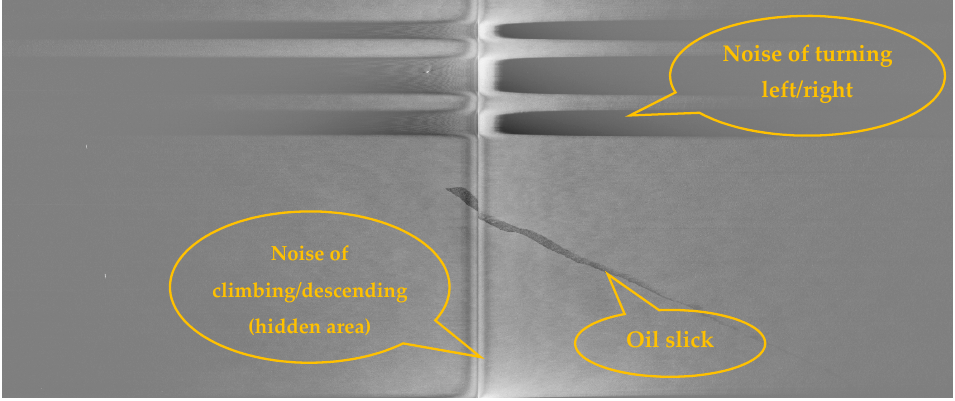
Figure 2. SLAR images acquired by a Terma-sensor mounted on aircraft: Example of oil spill with noise caused by aircraft maneuvers.